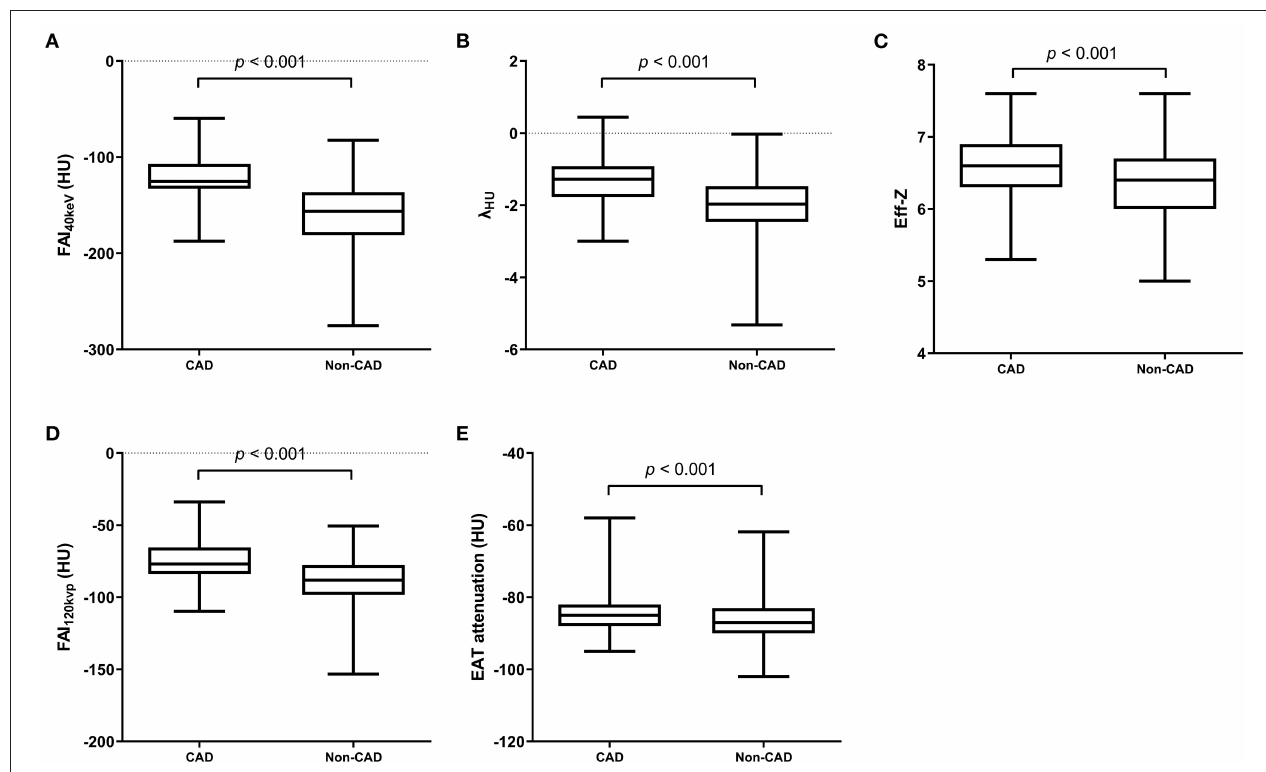
FIGURE 3 | SDCT-related parameters of PCAT and EAT attenuation in CAD and non-CAD groups. FAI40keV (A) , λ HU (B) , Eff-z (C) and FAI120kvp (D) and EAT attenuation (E) were significantly larger in patients with CAD than those in non-CAD group (both p < 0.001). A value of p < 0.05 indicated statistical